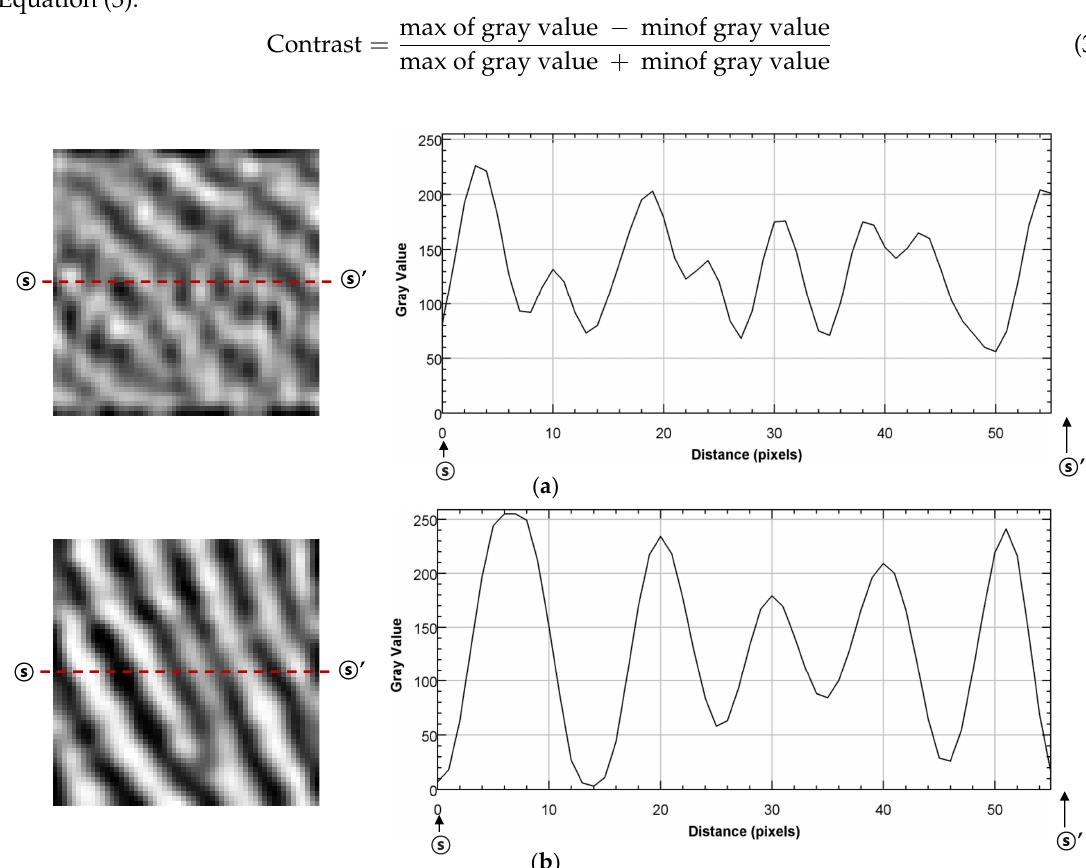
Figure 11. Comparison of gray values of images captured for a real finger, for the systems with and without an air-wall: ( a ) without an air-wall in the passivation layer; ( b ) with an air-wall in the passivation layer.